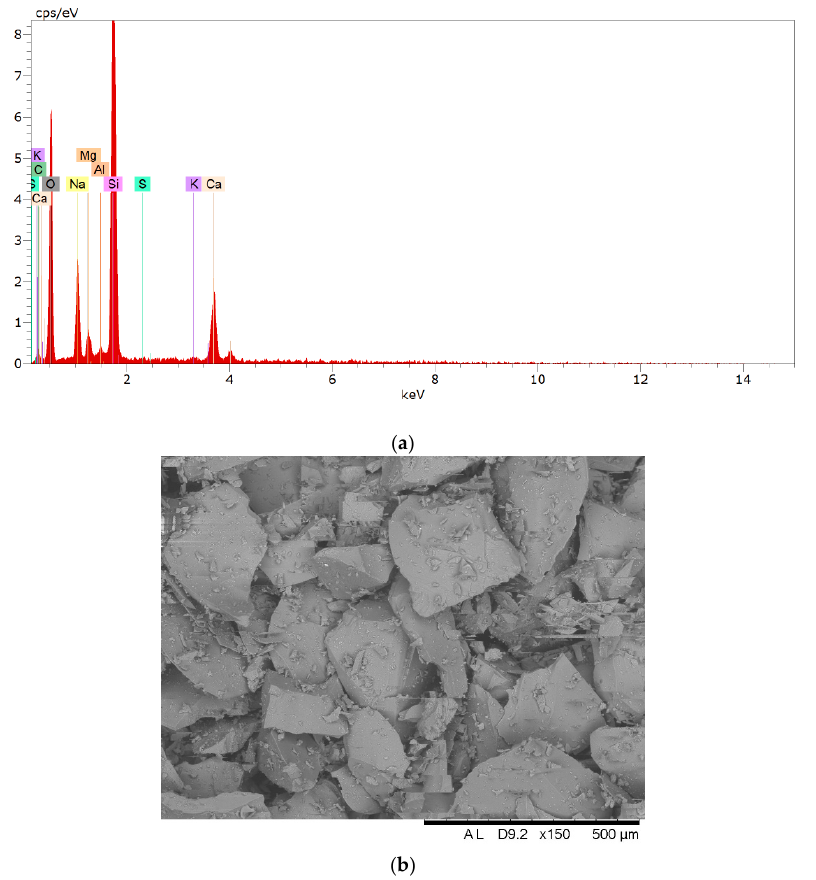
Figure 1. EDX output from a Honda windshield sample ( a ) and associated SEM image ( b ).